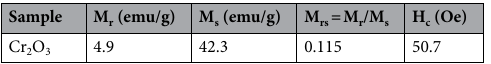
Table 1. Magnetic parameters of the